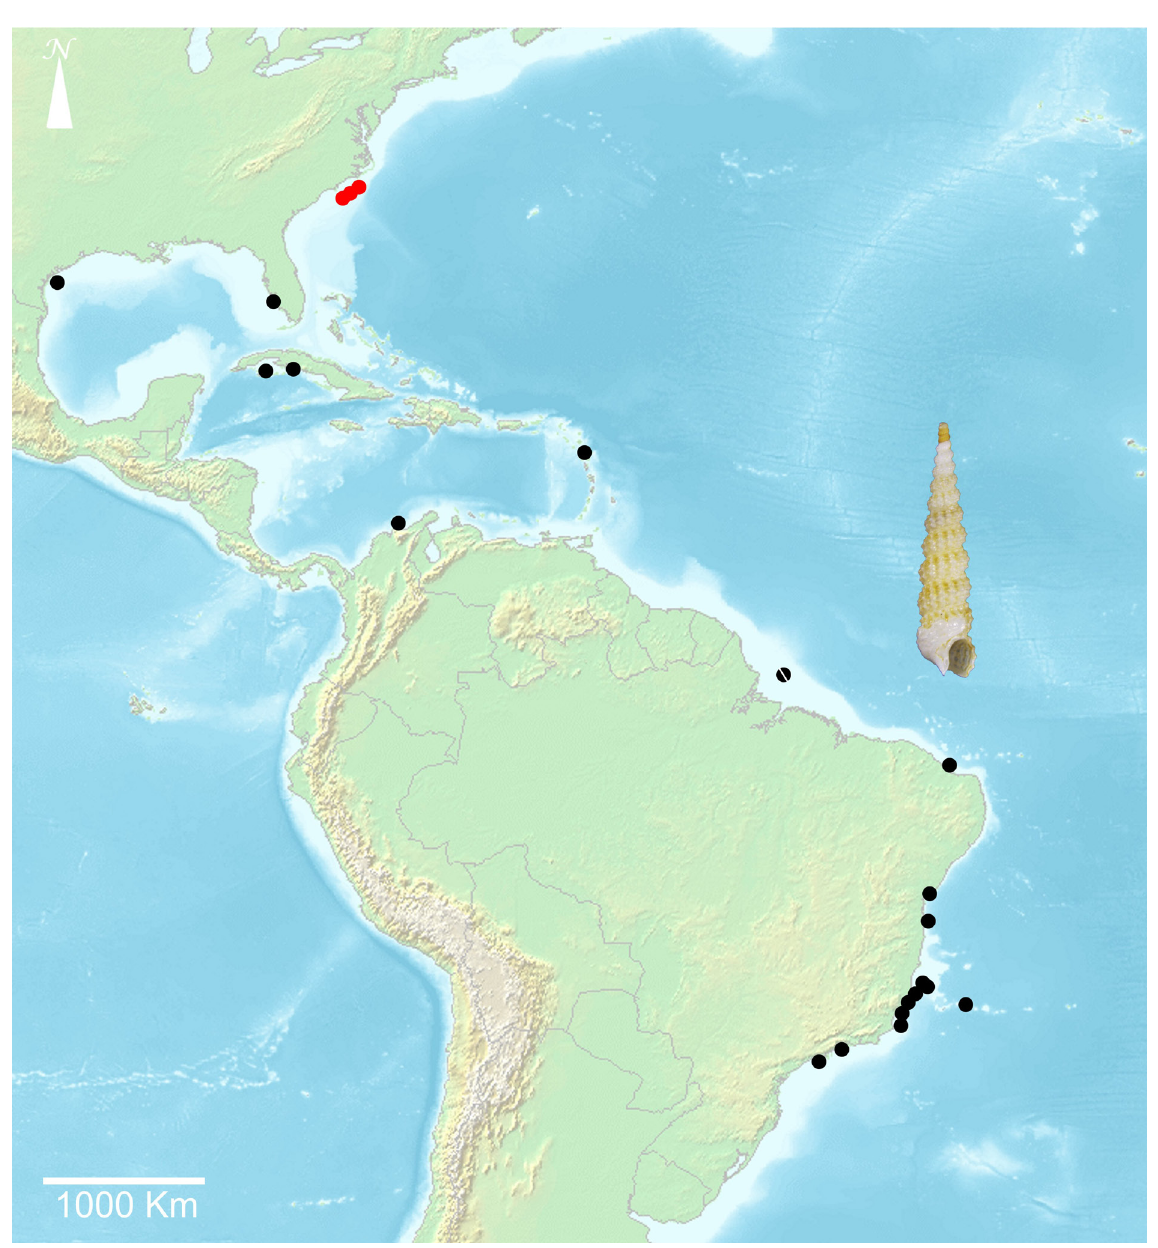
Fig. 27. Distribution map of Metaxia taeniolata (Dall, 1889); red circles = type